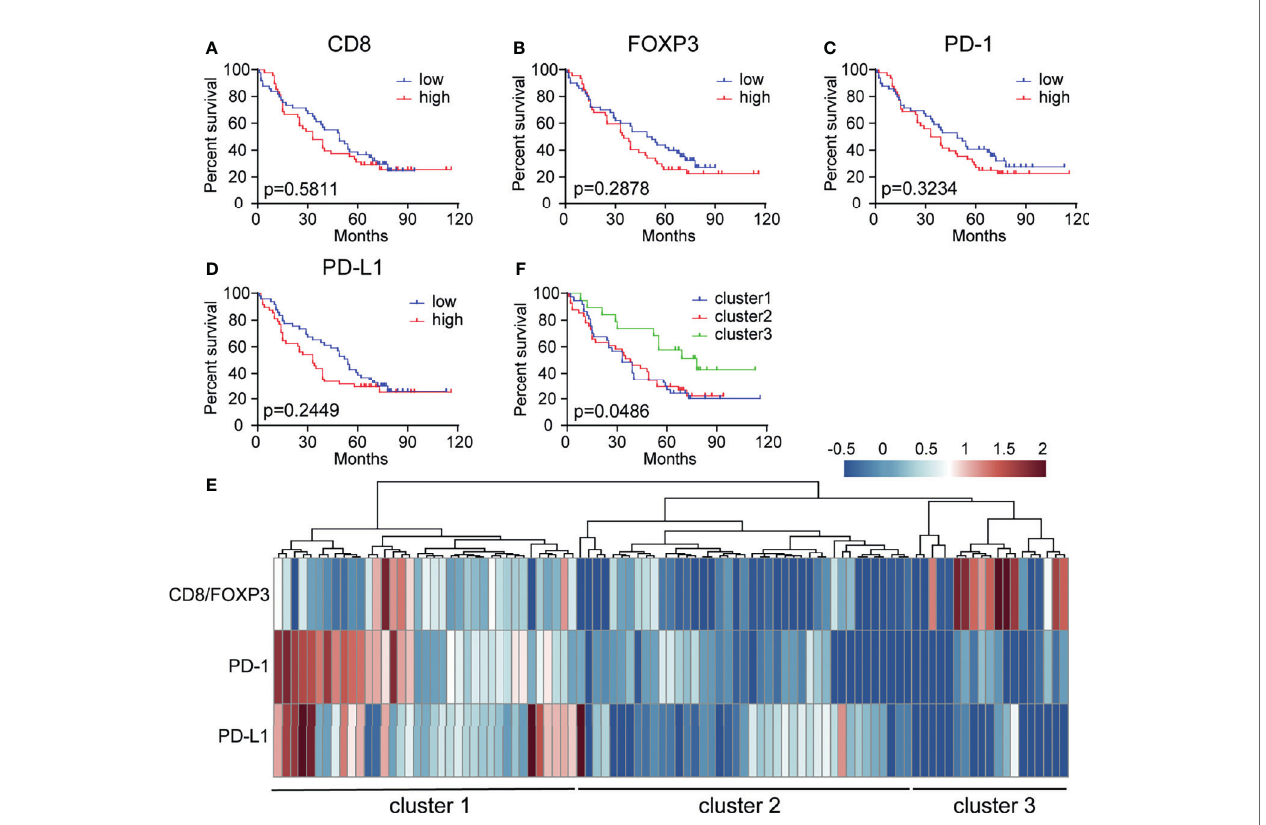
FIGURE 4 | Patient strati fi cation based on CD8+, FOXP3+, PD-1+ and PD-L1+ cell density has prognostic value. (A – D) Kaplan – Meier curve showing the prognostic effect of CD8, FOXP3, PD-1, and PD-L1 expression levels on overall survival (OS) in 97 NSCLC patient samples. The median cutoff value was used to distinguish between the high and low groups. A log-rank test was used to determine signi fi cance. (E) Patient strati fi cation based on hierarchical clustering of the CD8/FOXP3 ratio, PD-1+ cells, and PD-L1+ cells in the peritumoral subregion. (F) Kaplan – Meier curve illustrating the prognostic effect on OS in three groups of patients strati fi ed based on the CD8/FOXP3 ratio and checkpoint marker expression [based on data from panel (E)